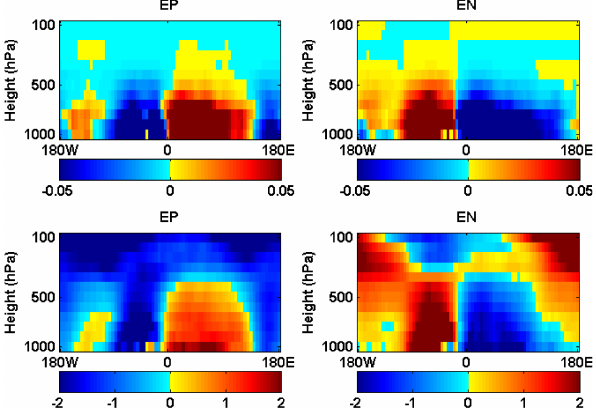
Fig. 11. The vertical distribution of water vapour mass mixing ratio anomalies (gkg − 1 ) (top row) and temperature anomalies (in K) de- rived using AIRS data averaged over 67–82 ◦ N during the EP and EN phases of the